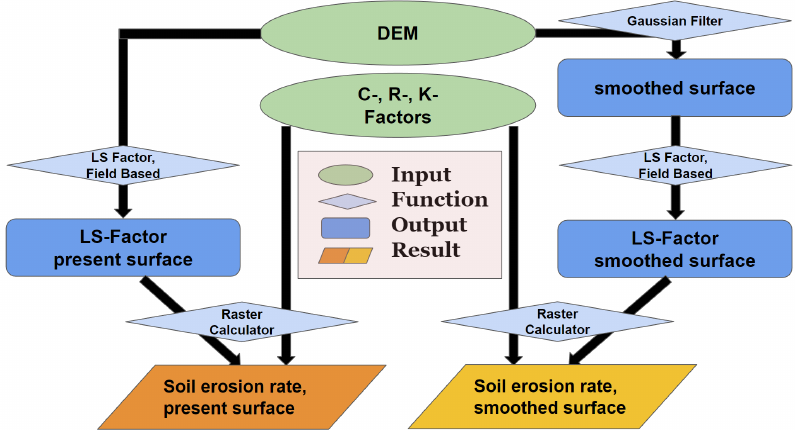
Figure 2. Flowchart of the GIS-based modelling procedure for both scenarios for calculating the potential soil erosion.